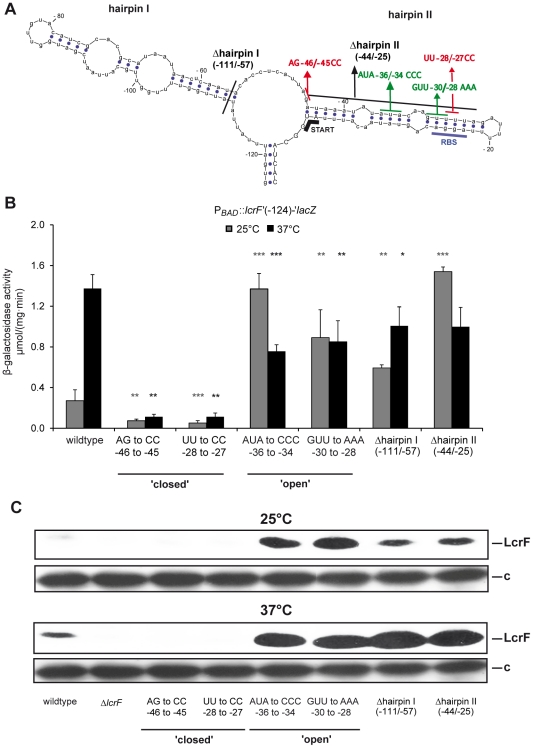
Predicted secondary structure of the lcrF RNA thermometer.(A) The Mfold program [81] was used for the prediction of the secondary structure of the yscW-lcrF 124 nt intergenic region. The most probable prediction with the lowest free energy is shown. The blue dots represent base pairing. The start of the protein synthesis at the AUG start codon (START) and the ribosome binding site (RBS) paired with the fourU motif are labelled. Deletion of the hairpin I and II are indicated. Nucleotide exchanges leading to increased complementarity are marked in red, mutations impairing base pair formation are given in green. Numbers indicate the nucleotides relative to the lcrF start codon. (B) Strains YPIII harboring the PBAD::lcrF′ (−124)-‘lacZ, including the different hairpin deletions or nucleotide exchanges were grown overnight in LB medium at 25°C or 37°C supplemented with 0.05% arabinose. β-Galactosidase activity from overnight cultures was determined and is given in µmol min−1 mg−1 for comparison. The data represent the average ± SD from at least three different experiments each done in duplicate. Data were analyzed by the Student's t test. Stars indicate the results that differed significantly from those of the wildtype at the same temperature with * (P<0.05), ** (P<0.01), and *** (P<0.001). (C) Y. pseudotuberculosis strains harboring the deletion and nucleotide substitution illustrated in (A) in the pYV were grown at 25°C and 37°C. Whole cell extracts of equal amounts of the bacteria were prepared, separated on a 15% SDS polyacrylamide gel, transferred onto a Immobilon membrane and intracellular LcrF was visualized by Western blotting. A higher molecular weight protein (c) that reacted with the polyclonal antiserum was used as loading control.